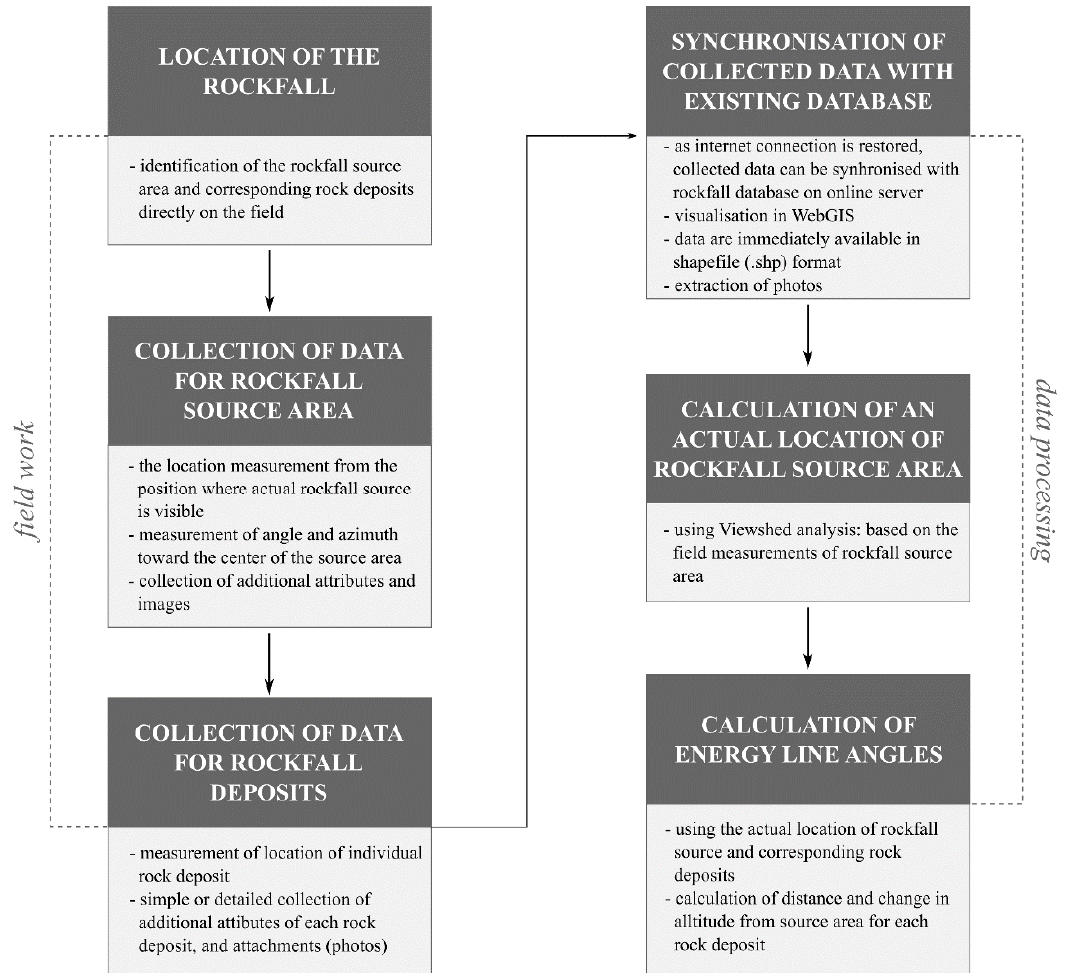
Figure 1. The methodological framework for collecting past rockfall events and calculating rockfall propagation statistics.